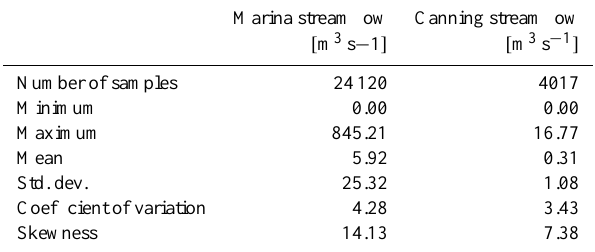
Table 3. Descriptive statistics of the output variable for Marina catchment and Canning River